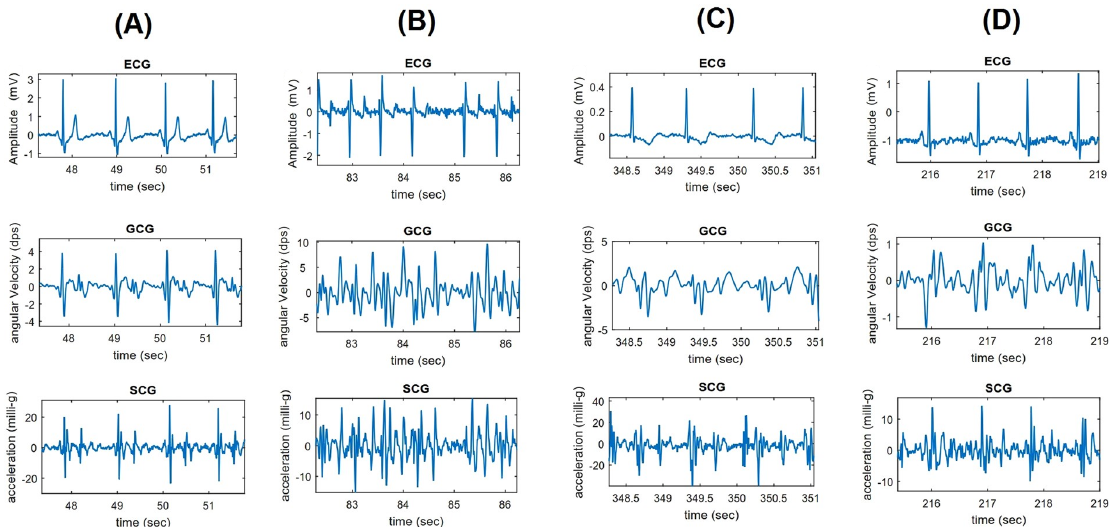
Figure 10. Overall ECG (lead I), GCG and SCG waveform characteristics of normal ( A ), atrial fibrillation ( B ), and coronary artery disease with ischemic changes: T-wave inversion ( C ) and ST segment depression ( D ). The work by Iftikhar et al. [55] under the CC-BY 4.0 license.